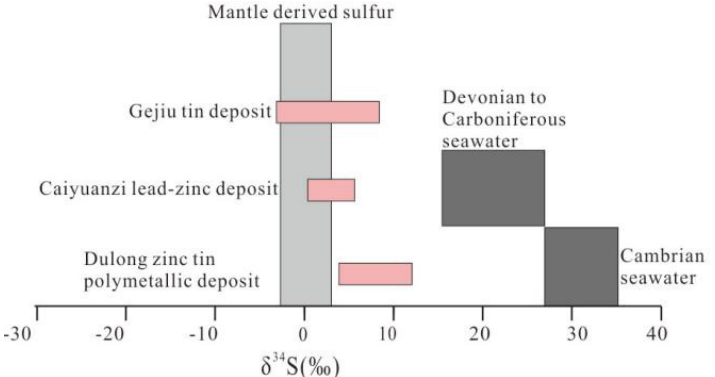
Figure 8. Comparison of sulfur isotopic composition between Pb–Zn deposits in strata of different ages in the Laojunshan region and seawater- and mantle-derived sulfur in the same period (the isotopic composition range of mantle derived sulfur is according to [52]; the sulfur isotopic composition range of seawater in the same period is according to [54]; the sulfur isotopic composition range of ore deposits is according to [10,42,51]).